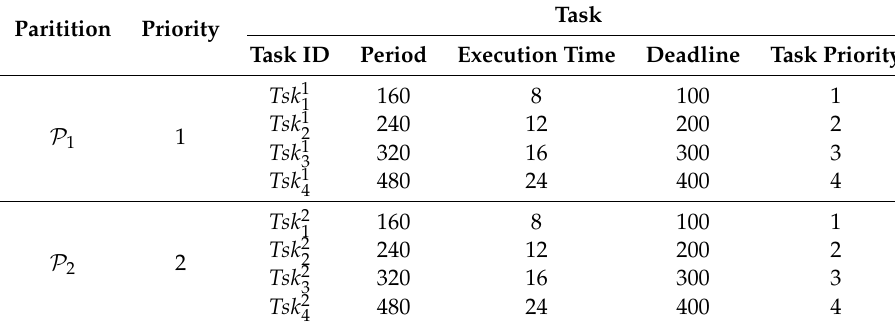
Table 5. IMA task set of Experiment